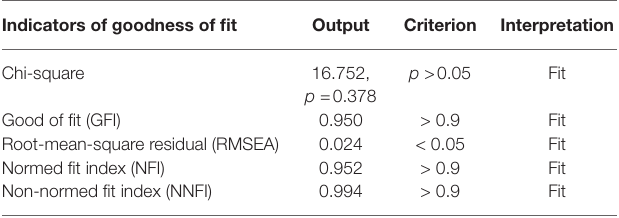
TABLE 1 | The analysis results of the goodness of fit of structural relationship model among variables. Indicators of goodness of